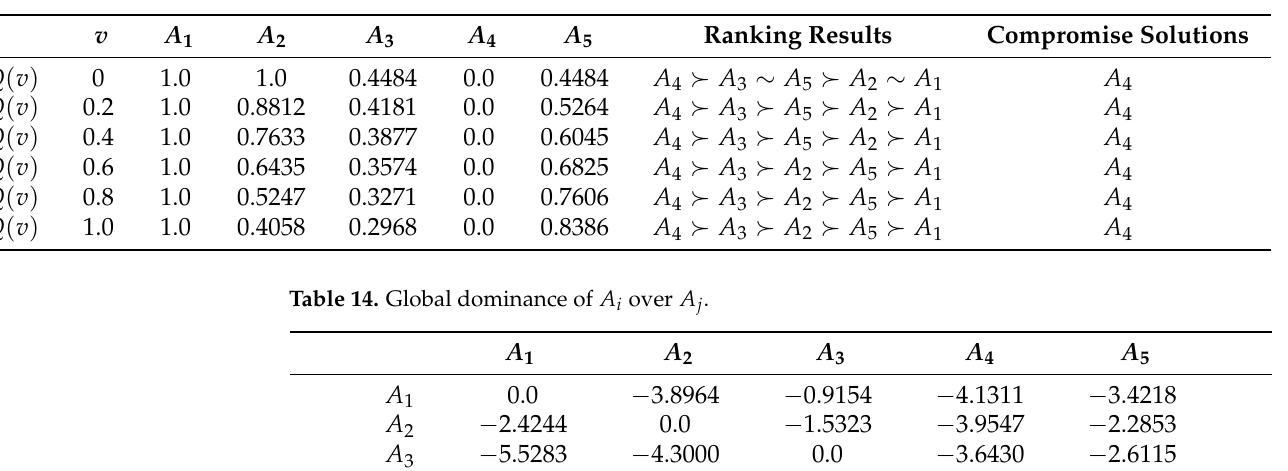
Table 13. Q i values of different v and compromise solutions.